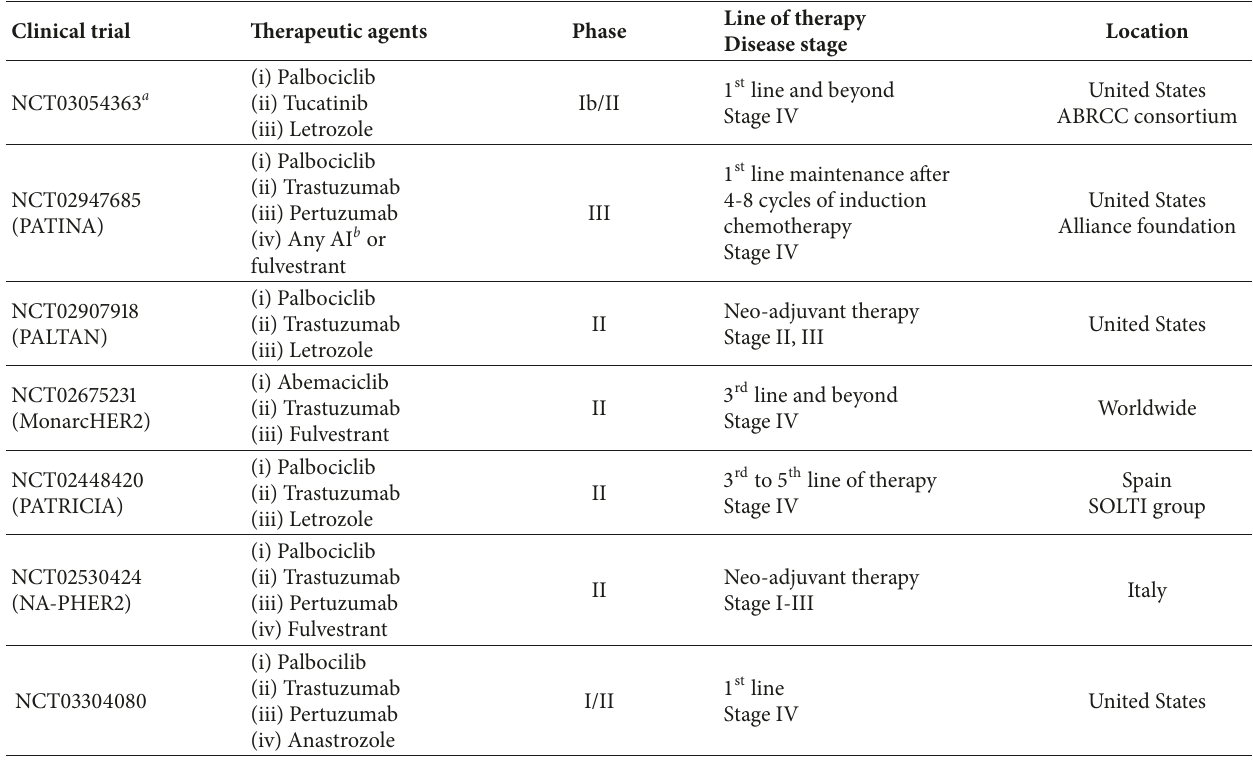
Table 2: Ongoing clinical trials combining CDK4/6 inhibitors with HER2-targeted and antihormonal agents in patients with HR+/HER2+ breast